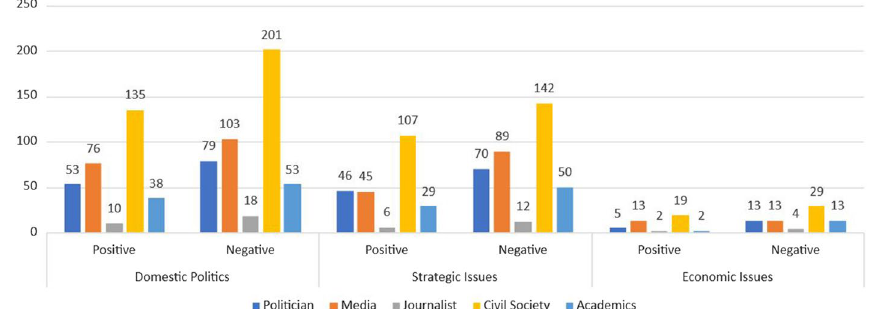
Fig. 10 Sentiment analysis of top 20 retweeted